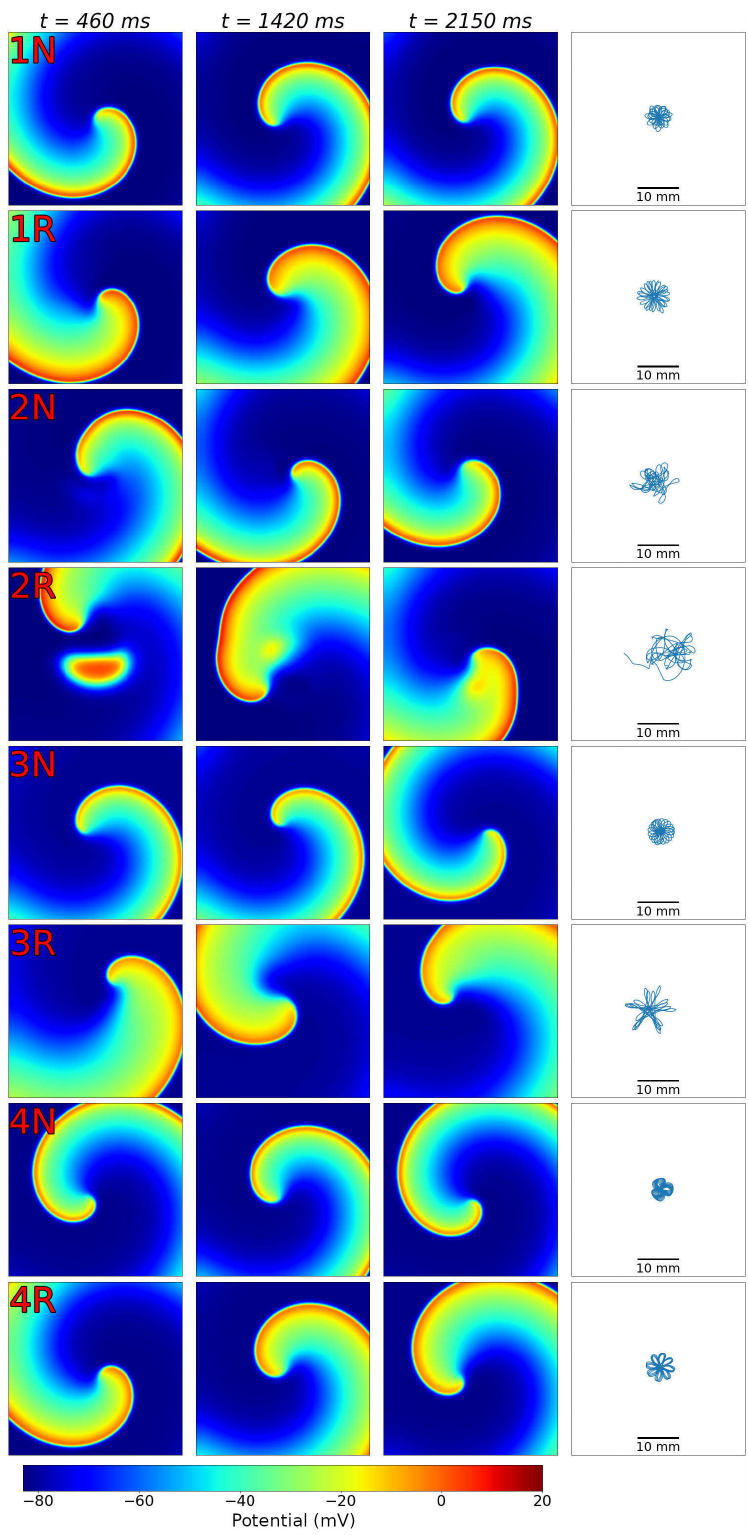
Figure 6. Spiral wave dynamics in 2D tissue models showing each of the four selected cellular models for normal tissue (N) and remodeled border zone tissue (R). Snapshots at several times are shown. Corresponding spiral wave core trajectories are shown in the right panels. Color scale for transmembrane potential is given at the